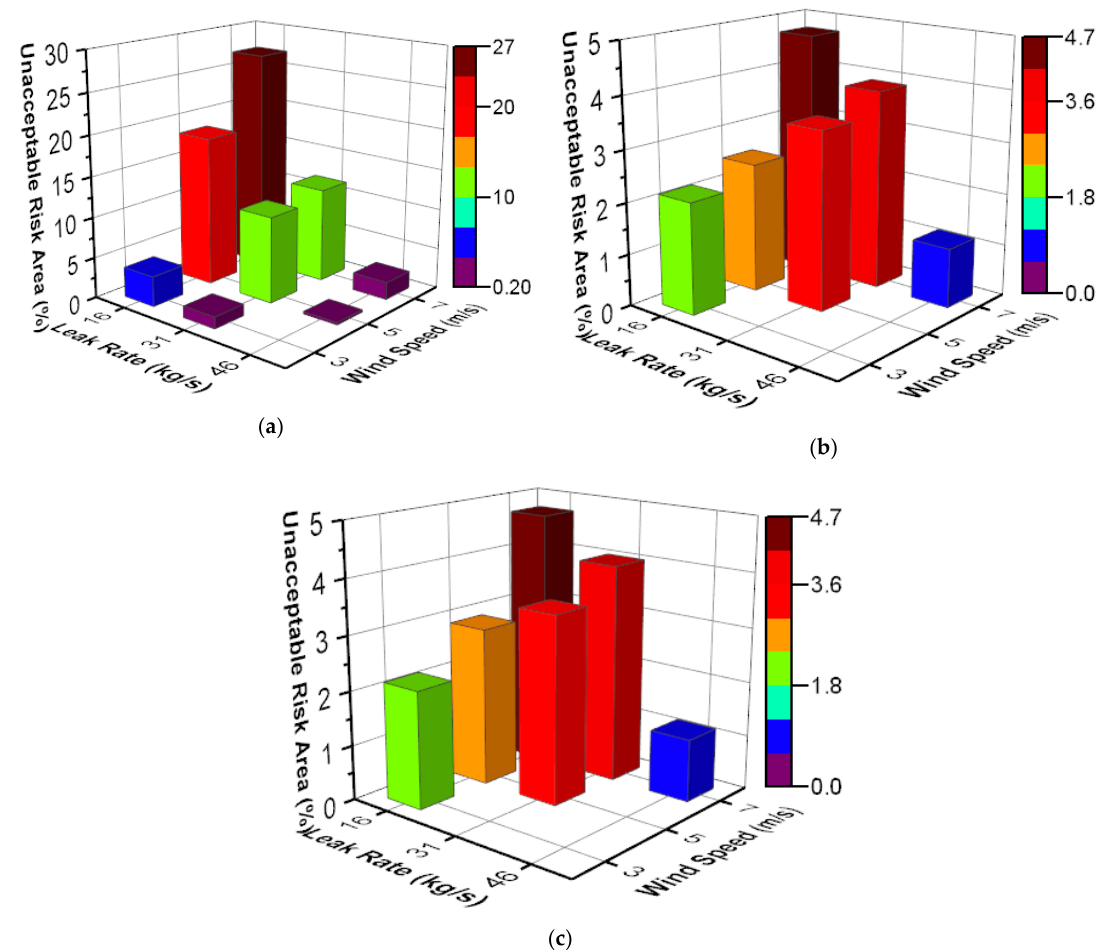
Figure 8. Unacceptable human fatality risk area for leak direction RX+ at year 1. ( a ) Head impact. ( b ) Lung damage. ( c ) Whole-body displacement.